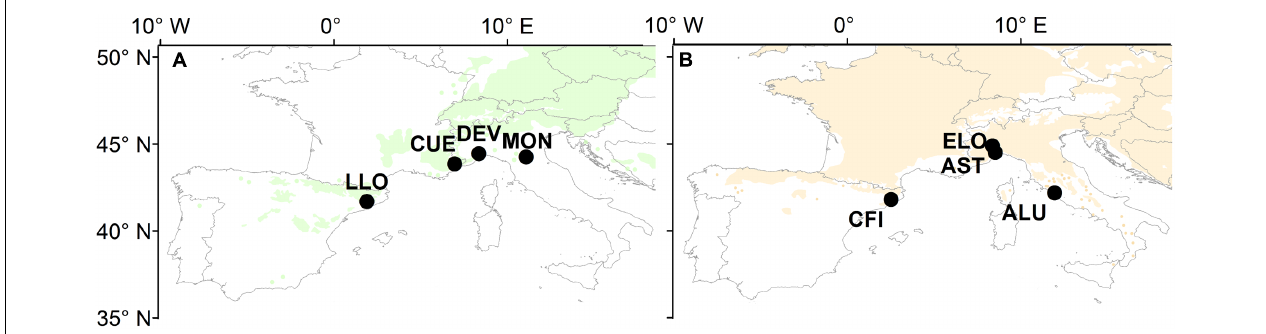
FIGURE 1 | Map of Europe showing the distribution of (A) Scots pine and (B) sessile oak and the location of the eight study sites (for details of the study sites, see Table 1 ). Maps are a modified version from those available at www.euforgen.org.